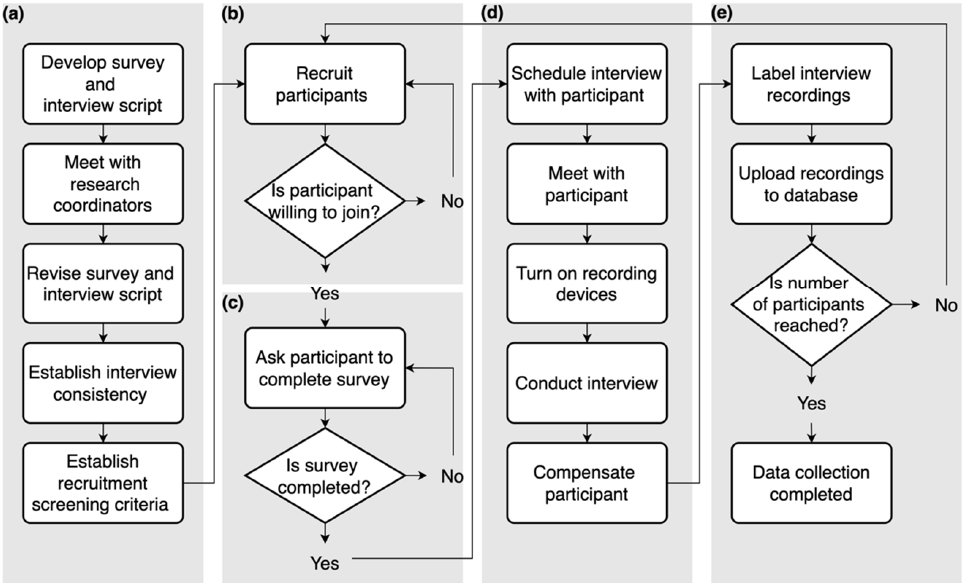
Figure 1. Flowchart of the interview process. ( a ): interview preparation; ( b ): participant recruitment; ( c ): survey data collection; ( d ): interview data collection; ( e ): interview data handling and comple- tion.